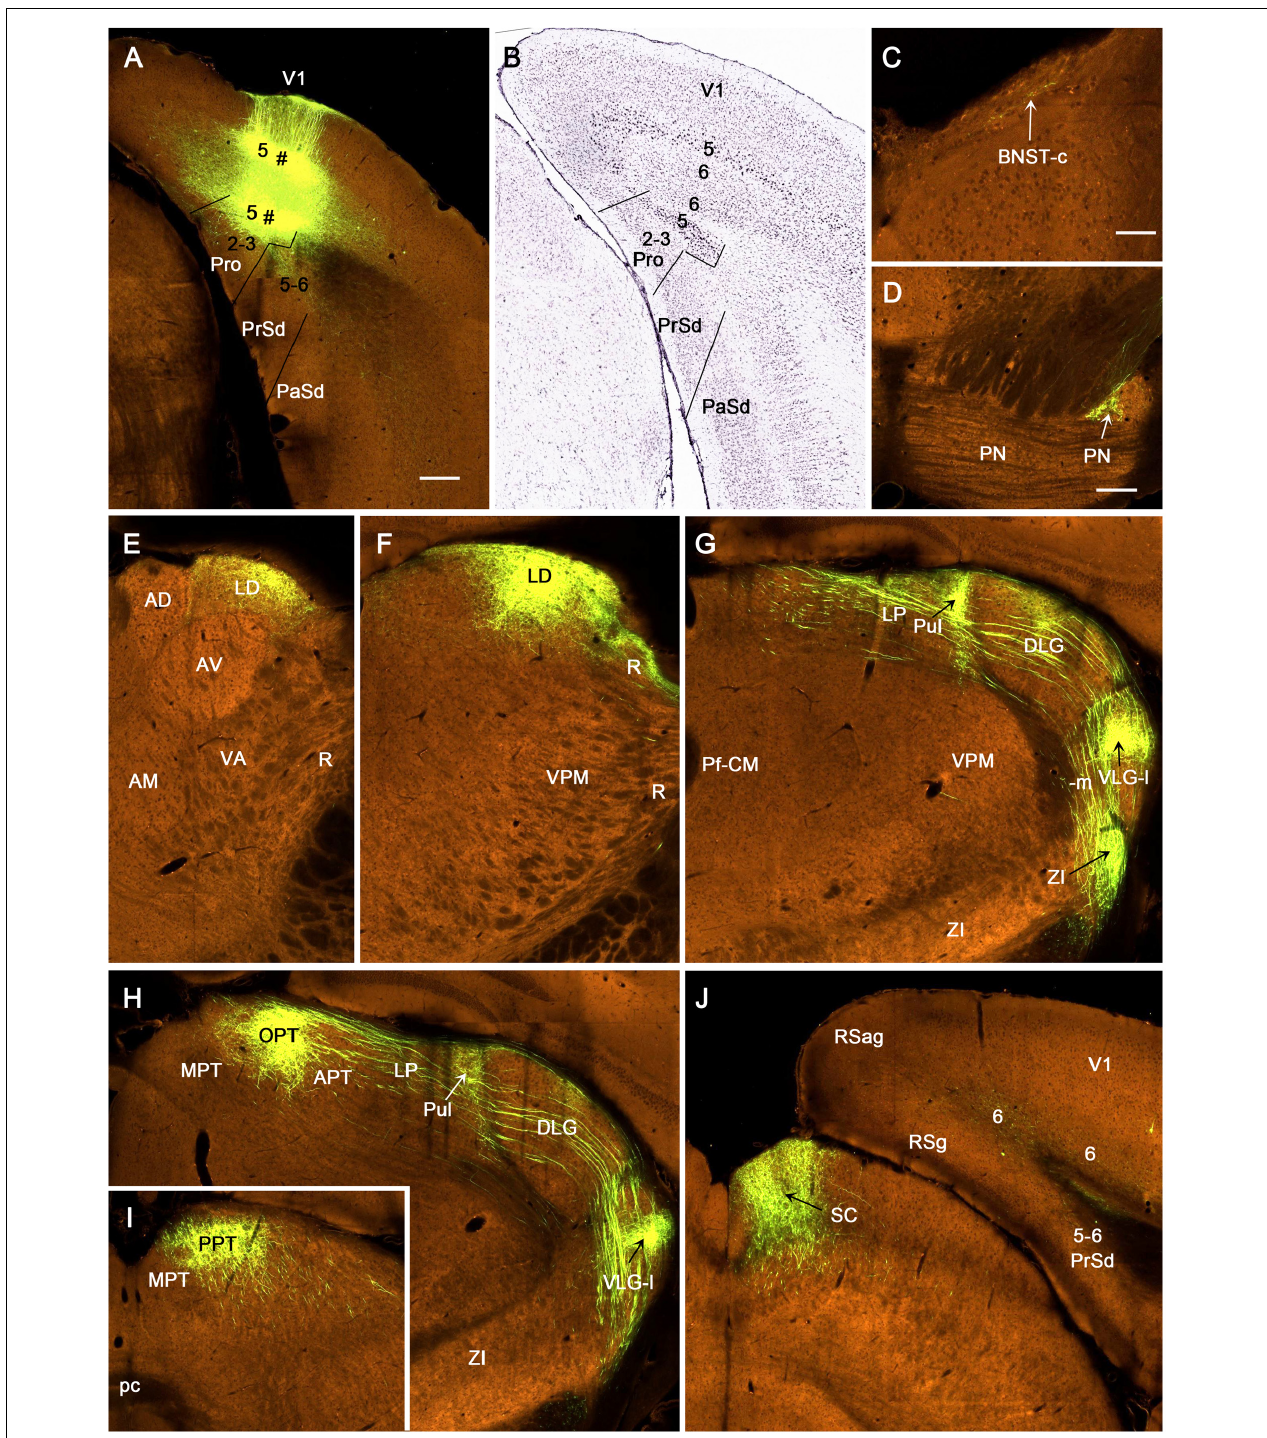
FIGURE 9 | Axon terminal labeling following an anterograde viral tracer injection in prostriata and V1 of a Npr3 -IRES2-Cre mouse. All panels are from coronal sections. (A) The injection site (marked by #) is involved in layer 5 of both prostriata and overlying V1. (B) One in situ hybridization (ISH)-stained section showing Npr3 -Cre expression mostly in layer 5 of the prostriata and V1. (C–J) Distribution of labeled axon terminals. Locations of some terminal labeling are indicated by the arrows. Relatively strongly labeled terminals are detected in layers 5–6 of the PrSd (A) , PN (D) , LD (E,F) , dorsal part of reticular thalamic nucleus (F) , LP-Pul (G,H) , lateral part of the VLG (VLG-l; G,H ), lateral part of zona incerta (G) , OPT and PPT of the PTN (H,I) , and medial part of the SC (J) . Weak terminal labeling is detected in the caudal part of the bed nucleus of stria terminalis (BNST-c in C ), DLG (G,H) , and layer 6 of RSg, RSag, and visual cortices (J) . Bars: 280 µ m (A) for (A,B) ; 0 µ m (C) ; 200 µ m (D) for (D–J)